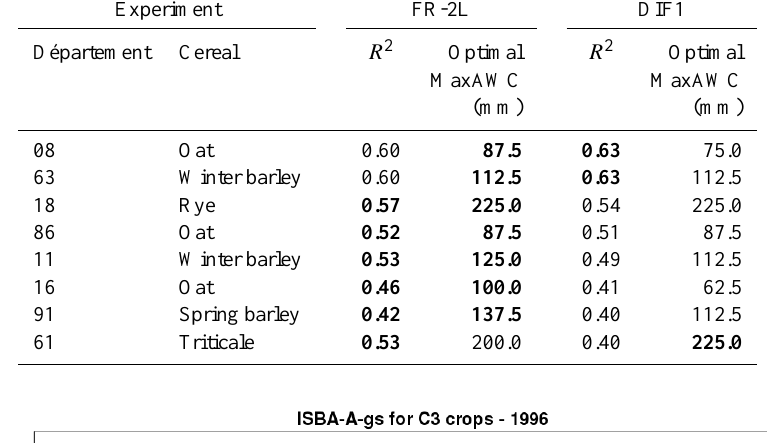
Table 3. Optimal MaxAWC and squared correlation coefficient ( R 2 ) between B ag ments where the same cereal Agreste data are used and where the correlation between B ag significant at least at the 1% level. The highest MaxAWC and R 2 values at a given département are in bold.